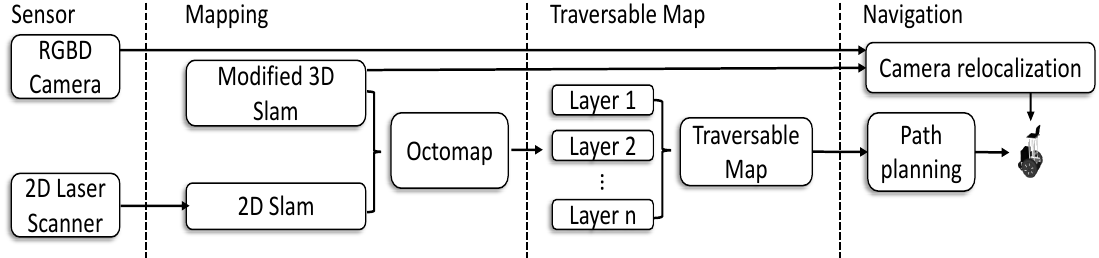
Figure 2. A schematic diagram of the system framework. The system uses a 2D laser scanner and an RGB-D camera. The mapping process outputs an OctoMap, which is cut into several layers to form a traversable map that is used for navigation